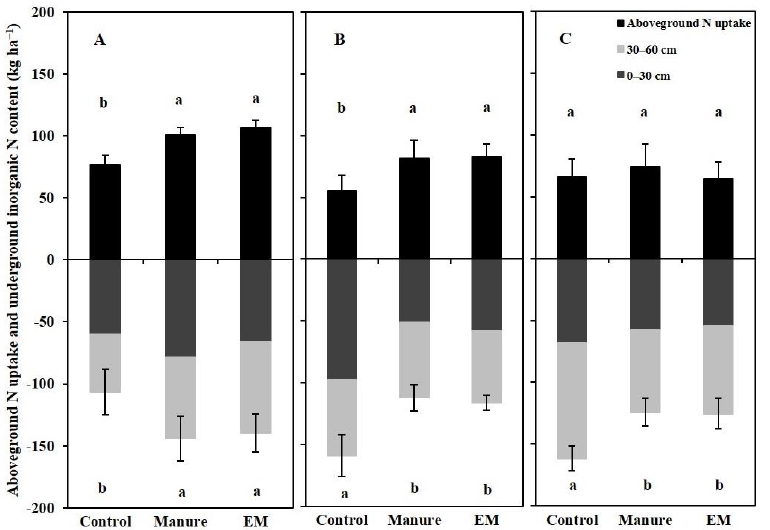
Figure 2. Soil inorganic N content (sum of NO 3 − -N and NH 4 − –N) at GS30 (start of stem elongation), GS61 (beginning of anthesis), and GS93 (physiological maturity) and the corresponding aboveground N uptake from sowing to GS30 ( A ), from the GS30 to GS61 ( B ), and from GS61 to GS93 ( C ) for three treatments across 3 years in 0–30 and 30–60 cm soil depth layers. Different letters indicate differences significant at p < 0.05 according to Fisher’s LSD test. Vertical bars represent ± S.E. of the mean.